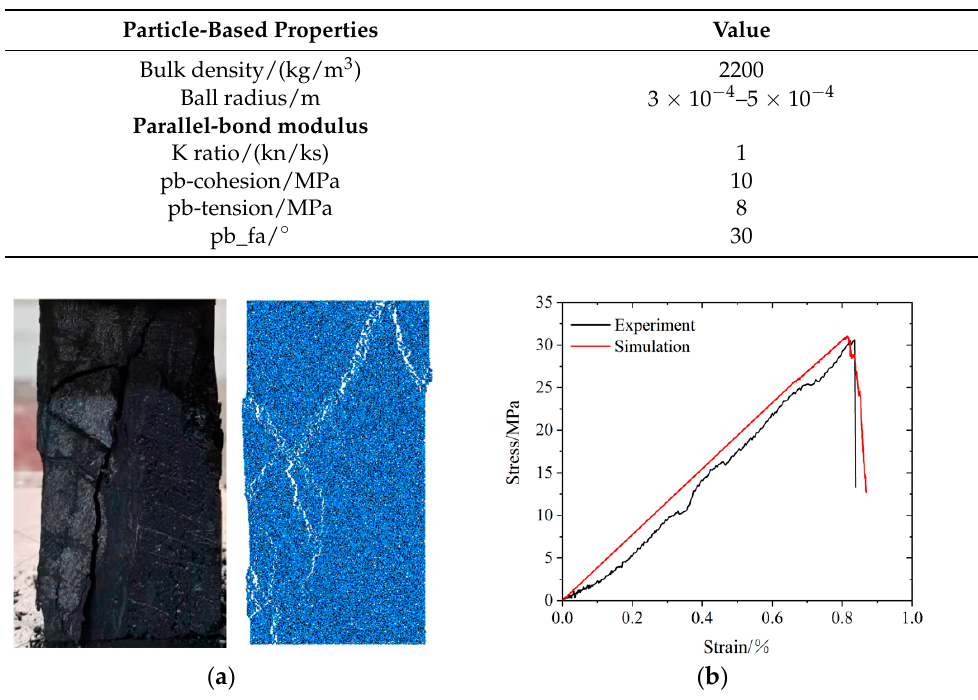
Figure 6. Failure mode and stress–strain of calibrations. ( a ) Failure modes, ( b ) Stress–strain. Table 1. Micro-parameters of specimen after calibration. Table 2. Micro-parameters of incident/transmitted bar after calibration. Particle-Based